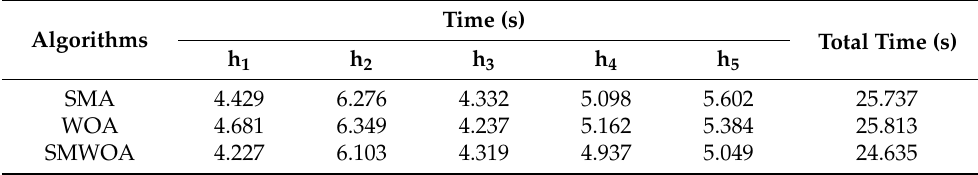
Table 6. Comparison of trajectory running